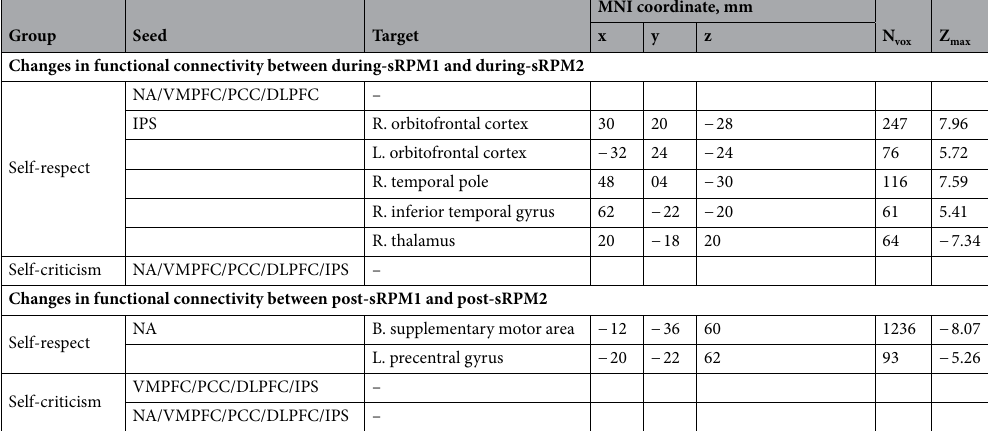
Table 4. Significant relationships between score increase rate of the short form of Raven’s Progressive Matrices (sRPM) and changes of functional connectivity in during-sRPM states and in post-sRPM resting-states in each of the self-respect and self-criticism groups. MNI Montreal neurological institute, N vox numbers of voxels, Z max maximum z-value within the cluster, L. left, R. right, B. bilateral, NA nucleus accumbens, VMPFC ventromedial prefrontal cortex, PCC posterior cingulate cortex, DLPFC dorsolateral prefrontal cortex, IPS intraparietal sulcus.